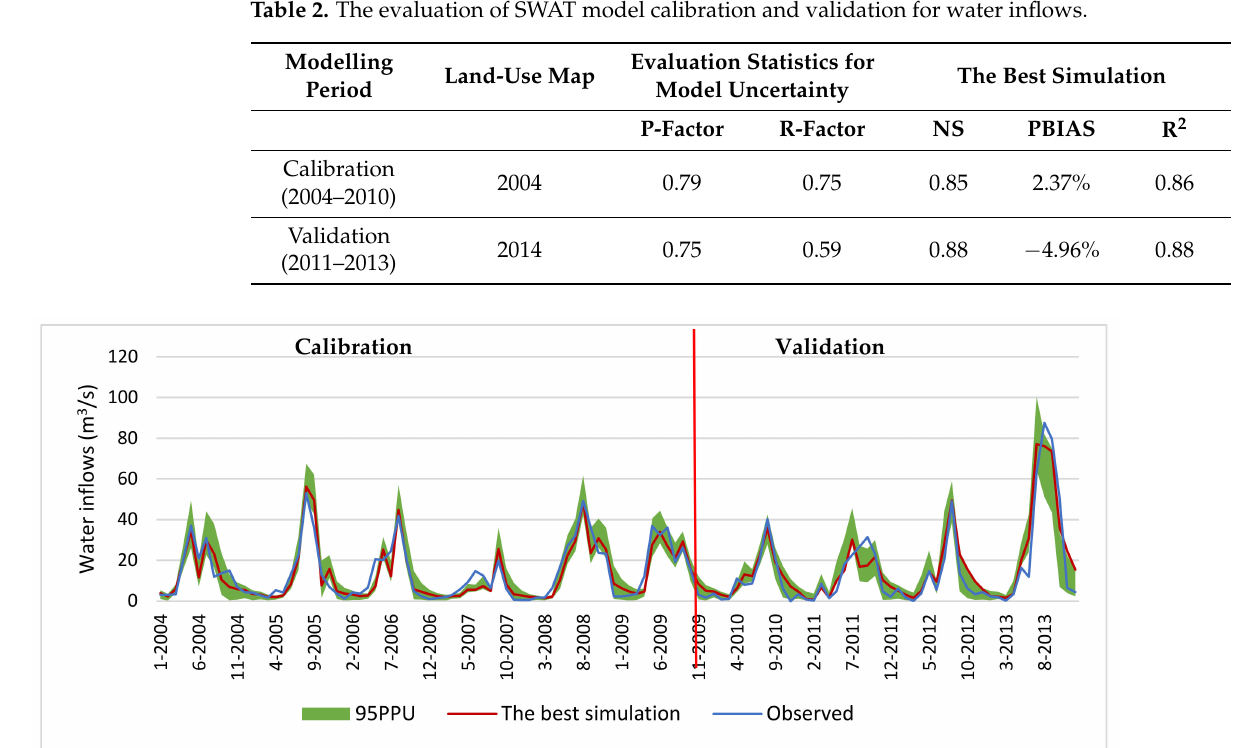
Figure 6. Calibration and validation of water inflows.